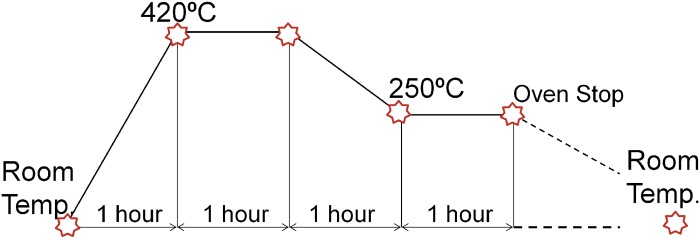
Annealing cycle.